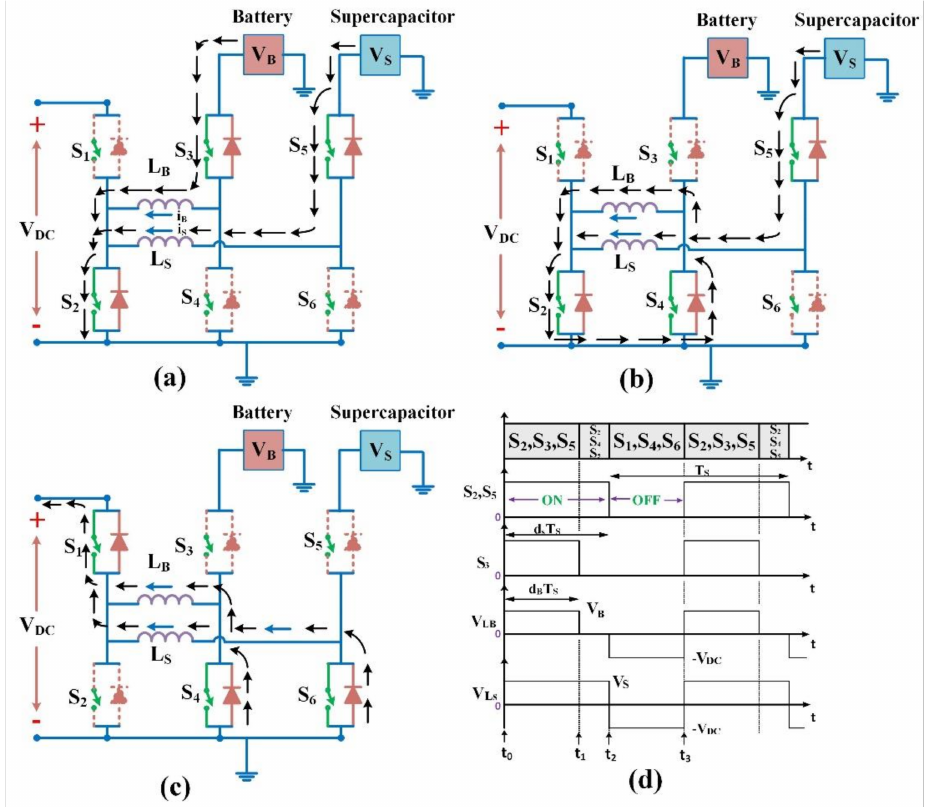
Figure 3. Two-input bidirectional converter equivalent circuit. ( a ) Operating switches S 2 , S 3 and S 5 ; ( b ) operating switches S 2 , S 4 and S 5 ; ( c ) operating switches S 1 , S 4 and S 6 and ( d ) discharging mode steady-state